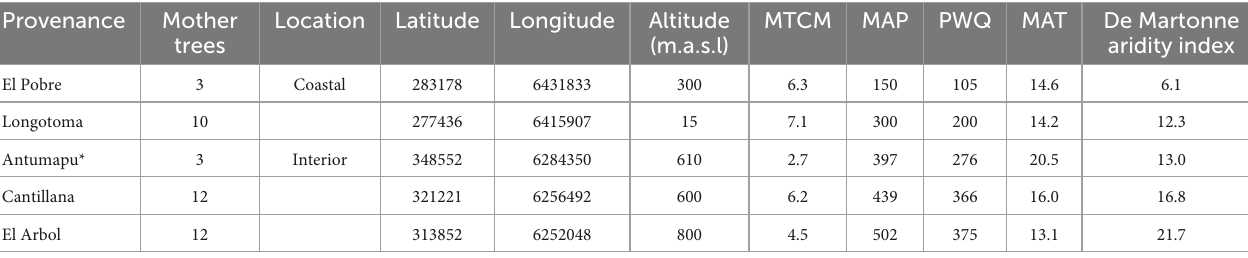
TABLE 1 Location and climate for the provenances and plantation of Beilschmiedi miersii under study. Provenance Mother